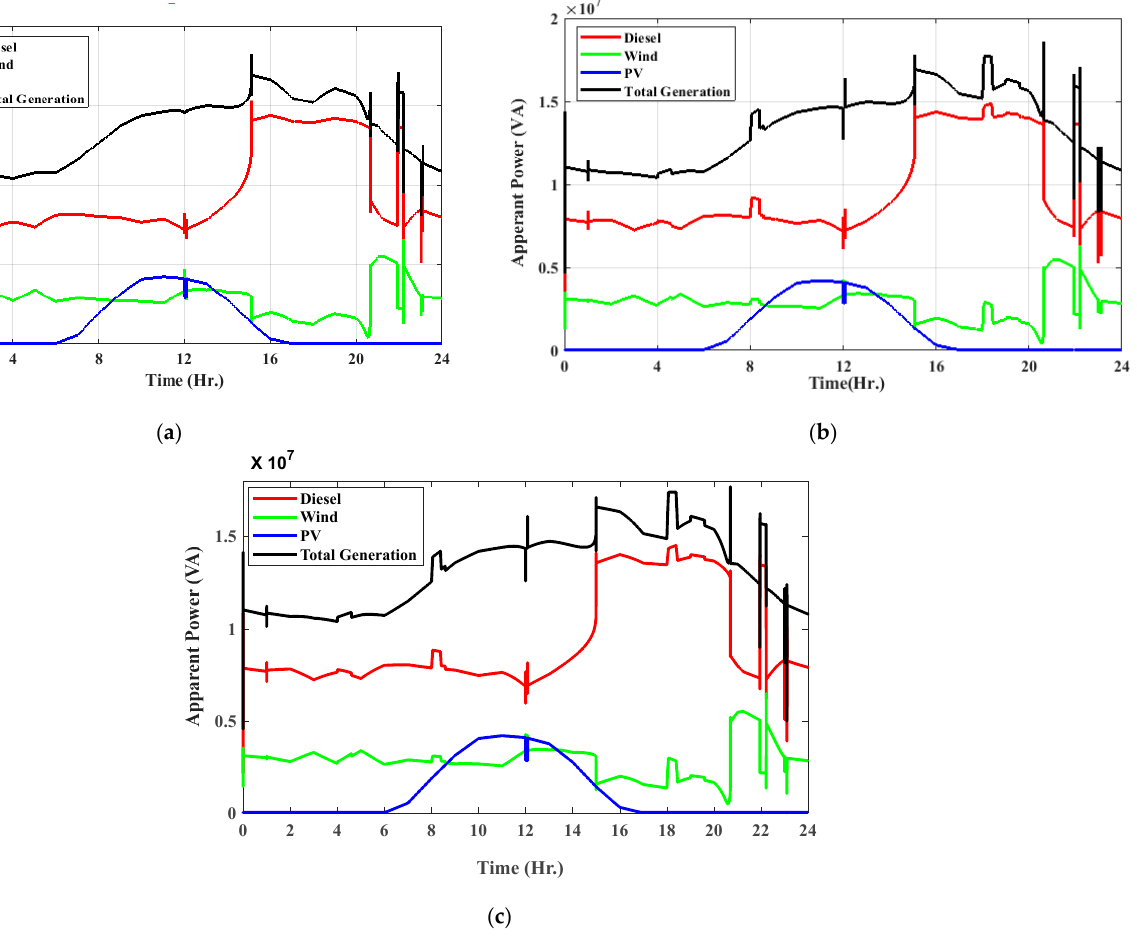
Figure 11. Total apparent power: ( a ) without any compensations; ( b ) with V2G compensations; ( c ) and with DSTATCOM and V2G compensations.